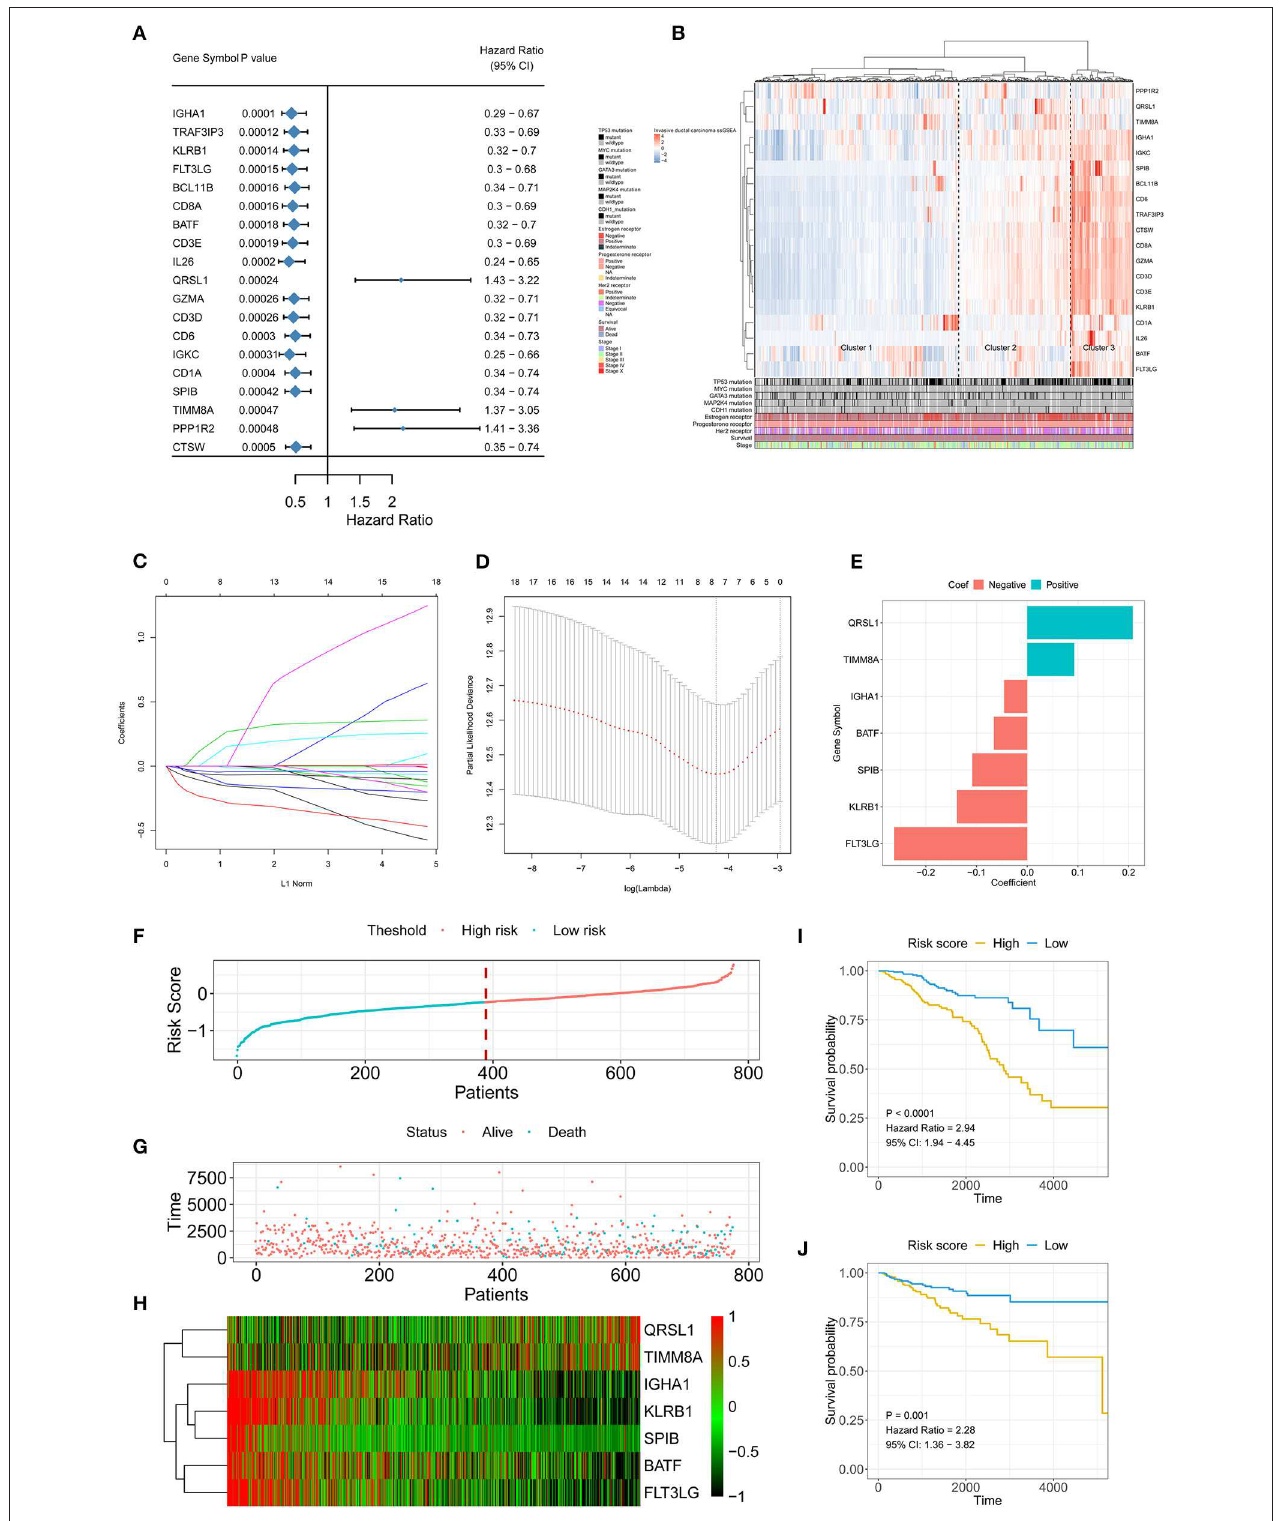
FIGURE 2 | Signature-based risk score is a promising marker of survival in IDC patients. (A) The HR and P -value from the univariable Cox HR regression of selected genes in the immune terms (Criteria: P -value < 0.001). (B) The expression of the selected genes shown by heatmap. Mutation status of TP53, MYC,